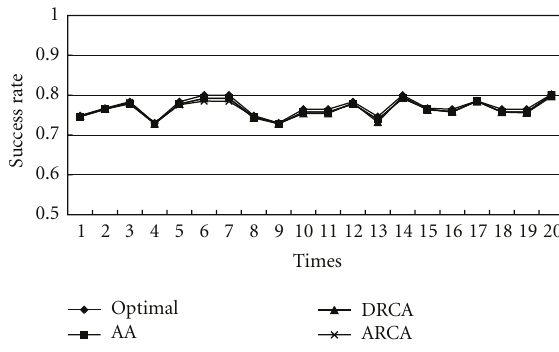
Figure 5: Total transmission success rate in Case 3.